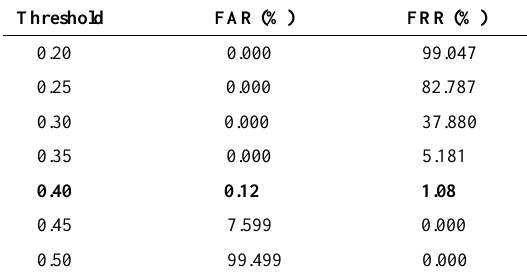
Figure 11. Transference of iris encoding to left and right side and finding best matching of HD. Table 4. FAR and FRR for the CASIA database with different value threshold using the optimum parameters.